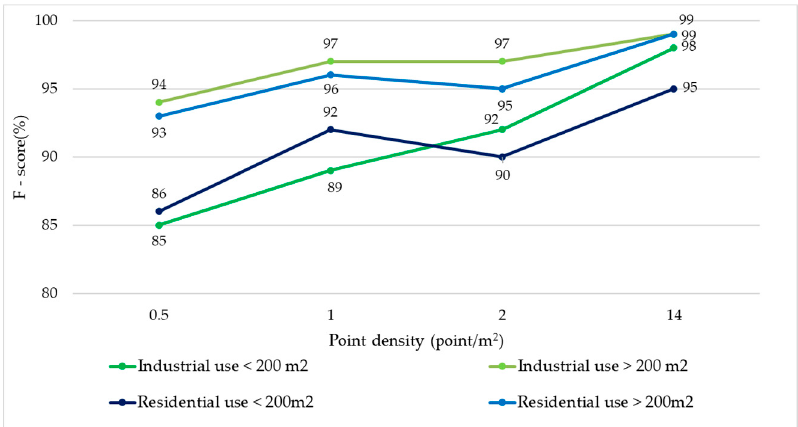
Figure 11. F-score (%) for the different the point cloud densities depending on the use of the building and the area of the roof.